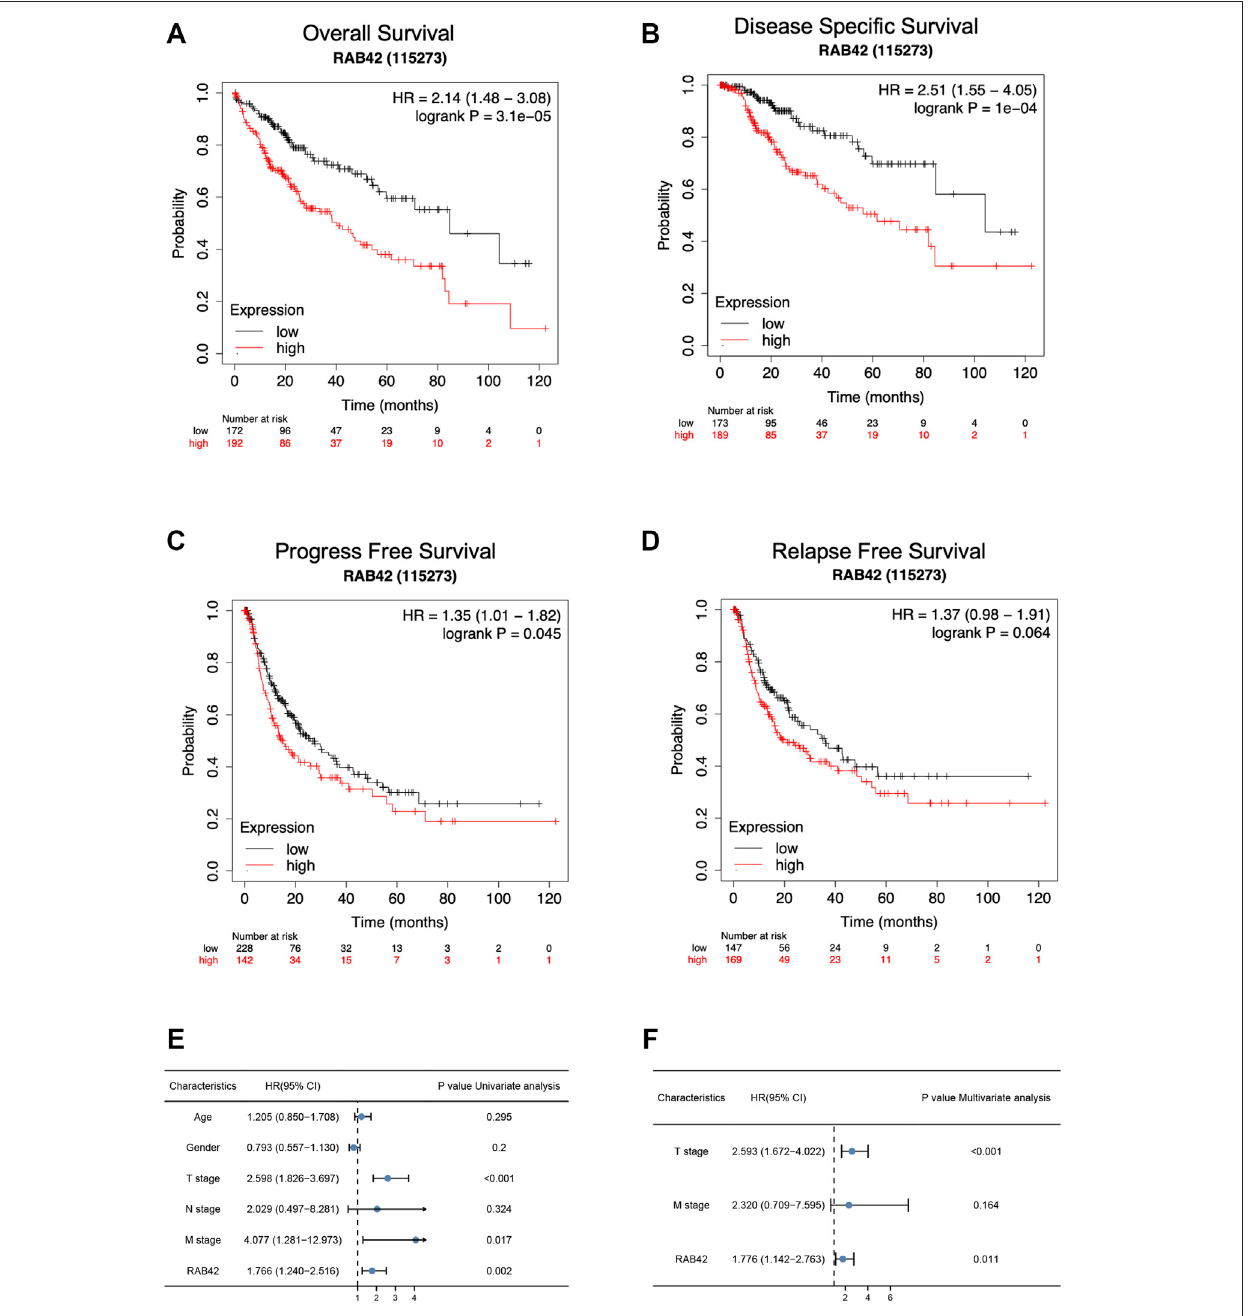
FIGURE3| Thesurvivalanalysisand theprognosticvalueofRAB42inHCC. (A – D) TheOS (A) ,DSS (B) ,PFS (C) ,and RFS (D) survivalcurvescomparingpatients with high (red) and low (black) RAB42 expression in HCC were plotted using the Kaplan – Meier plotter database at the threshold of the p -value of < 0.05. (E) Univariate Cox regression analyses of OS-related factors in HCC from TCGA dataset. (F) Multivariate Cox regression analyses of OS-related factors in HCC from TCGA dataset. HCC, hepatocellular carcinoma; OS, overall survival; DSS, disease speci fi c survival; PFS, progress free survival; RFS, relapse free survival.